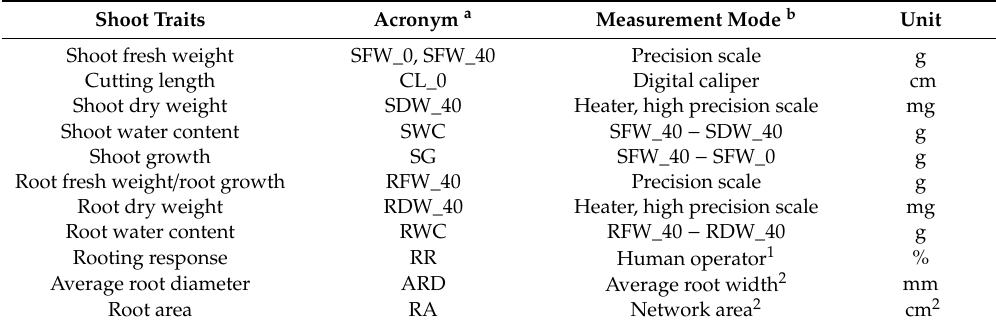
Figure 4. Adventitious rooting in the third experiment. ( a ) Rooting response measurements and ( b ) average root area (cm 2 ) values in the studied lines at 19, 29, and 40 dap. Letters indicate significant di ff erences between samples (LSD; p -value < 0.05). ( c ) Representative images of the 2101-02 MFR parental line (up) and two lines with contrasting adventitious rooting phenotypes: the L192 bad rooting line (left down) and the L062 good rooting line (right down). Scale bar: 25 mm. Table 2. Selected shoot and root traits measured in the third